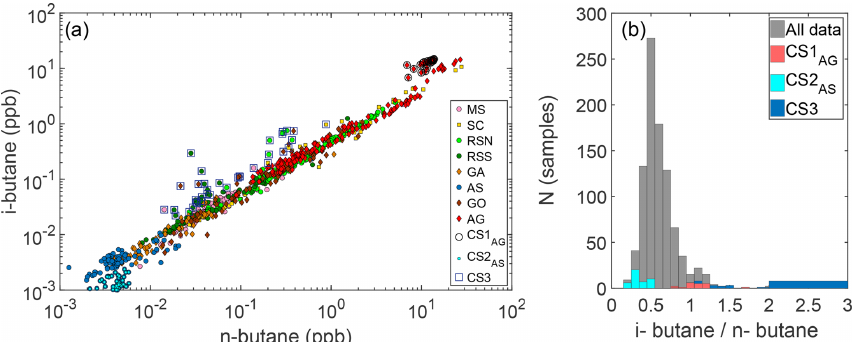
Figure 12. (a) Relationship between butane isomers and (b) distribution of the i -butane /n -butane ratio considering all data (grey bars) and the case study data (blue and red bars) as they have been selected from (a) .